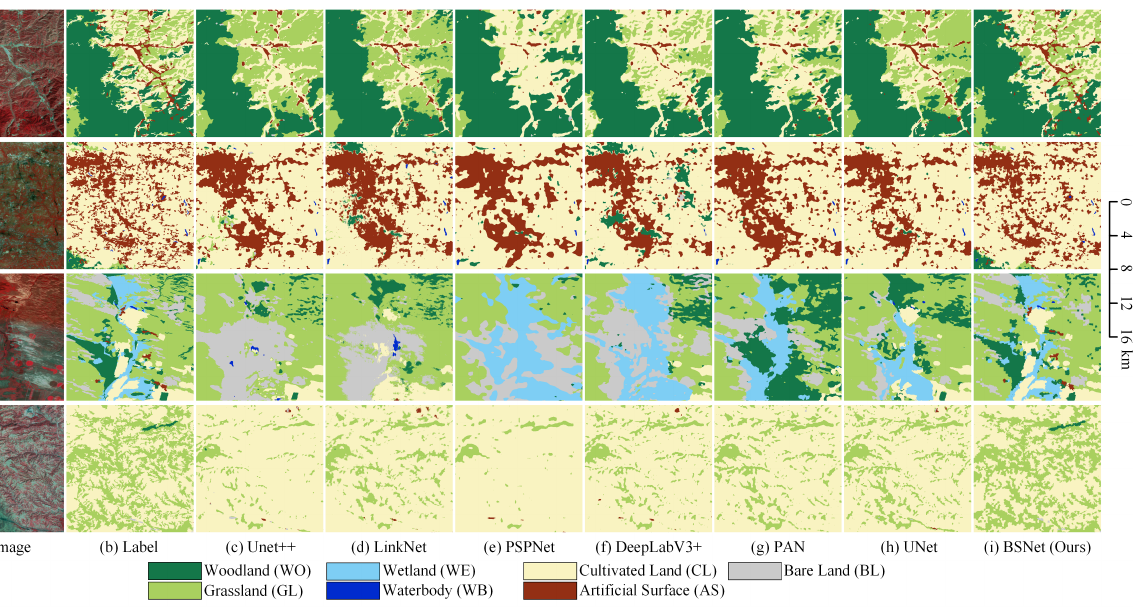
Figure 12. Some examples of the results on the Landsat core dataset. Comparison between our BSNet and other methods. ( a ) Landsat image. ( b ) Ground truth. Inference result of ( c ) the UNet++, ( d ) the LinkNet, ( e ) the PSPNet, ( f ) the DeepLabV3+, ( g ) the PAN, ( h ) the UNet, and ( i ) our proposed BSNet. In the third row, grassland, woodland, bare land, cultivated land, and wetlands